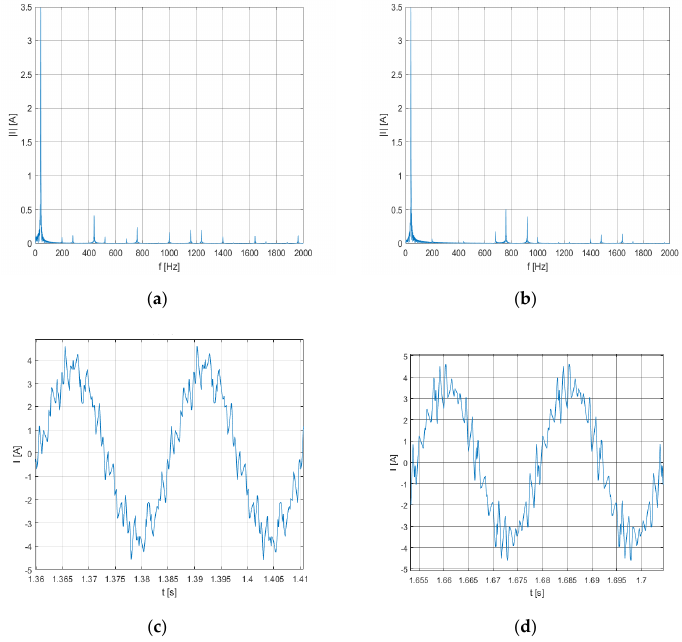
Figure 6. Comparison of the line current waveform and spectrum of harmonics for the fundamental